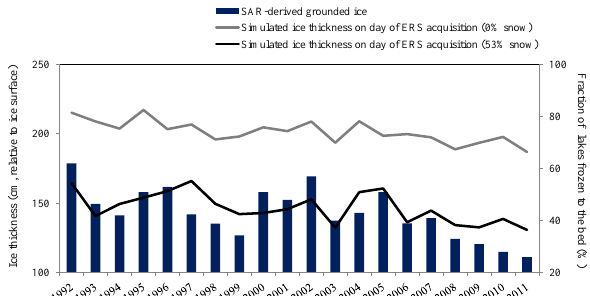
Fig. 6. SAR-derived fraction of grounded ice and simulated Figure 6. SAR-derived fraction of grounded ice and simulated ice thickness from CLIMo on day of ERS acquisitions from 1992 to 2011.